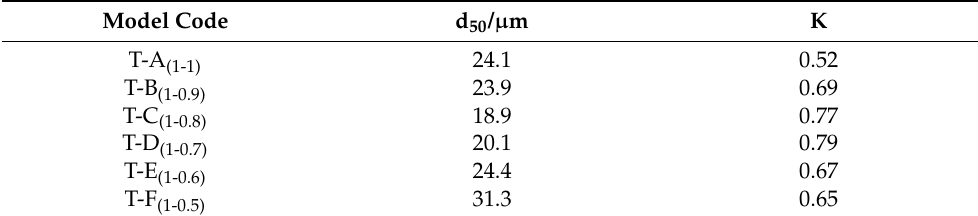
Table 7. Comparison of d 50 and K for the six different rotor cage models (13.5 m/s–670 rpm). Model